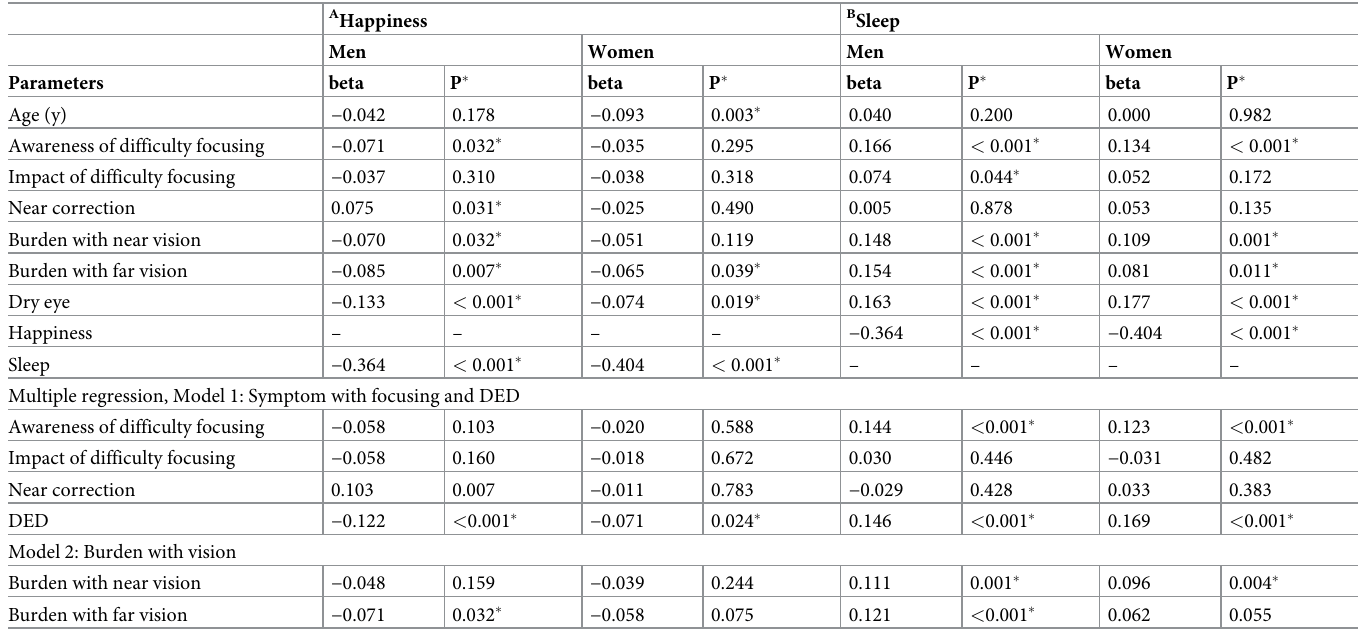
Table 5. Regression analysis for happiness and sleep stratified with